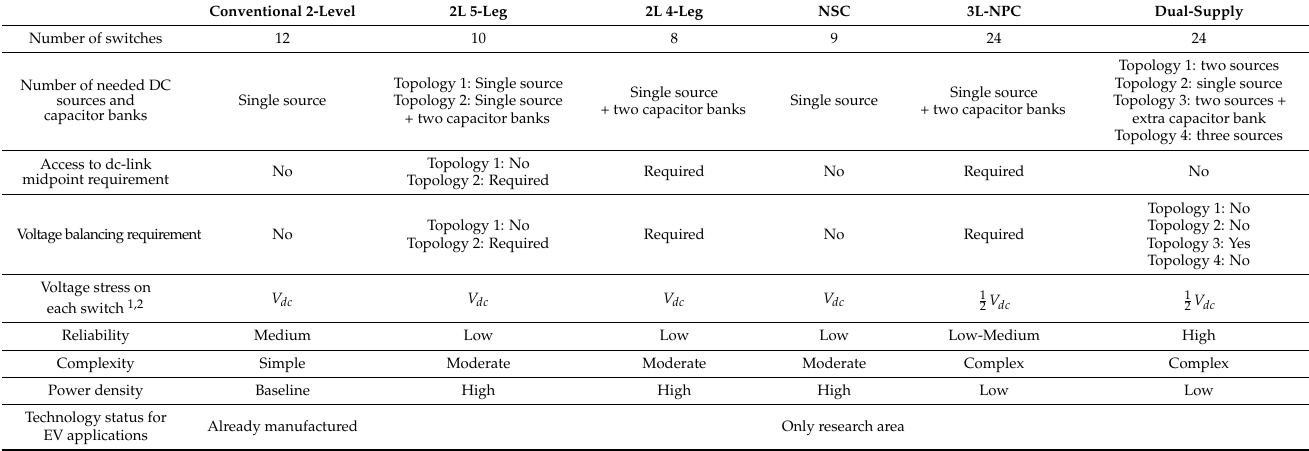
Table 3. Comparison between different converter topologies for six-phase drives.